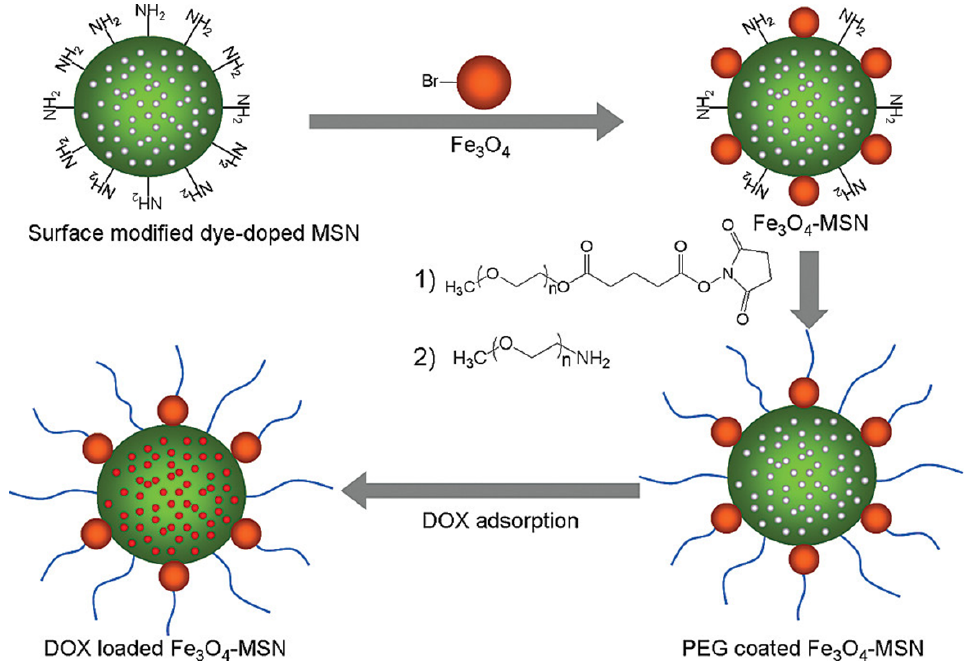
Scheme 3. Schematic illustration of the synthesis of DOX-loaded PEG-coated Fe 3 O 4 -MSNs for